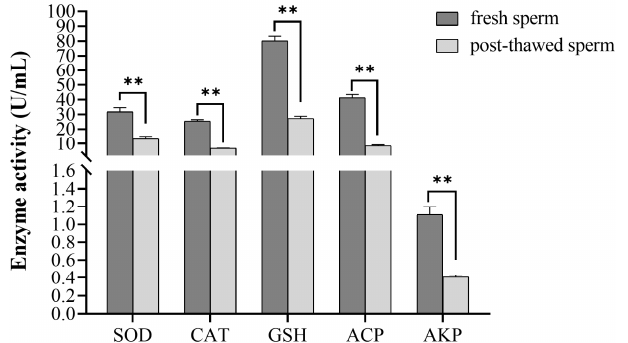
Figure 8. The enzyme activity analysis of fresh and frozen sperms. ** means that the difference is sig- nificant ( p < 0.05) ( n =